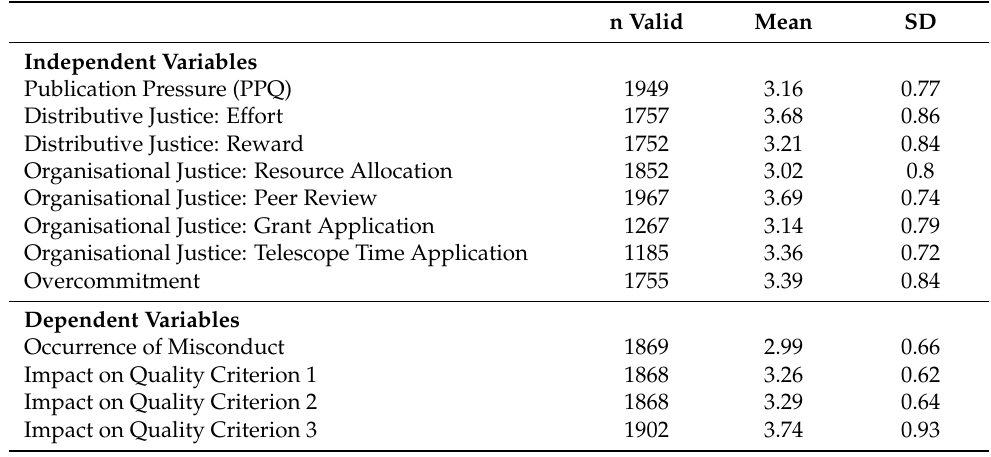
Table 2. Means and standard deviations of the independent and dependent